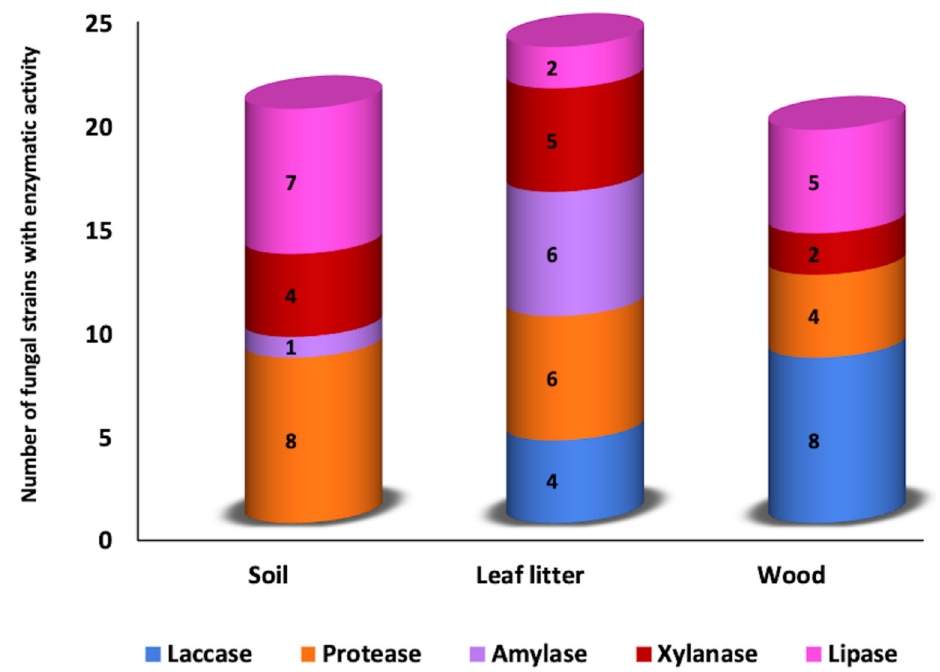
Figure 1. Distribution of the enzymatic activity of fungal strains and their relationship with isolation substrates from a tropical forest.